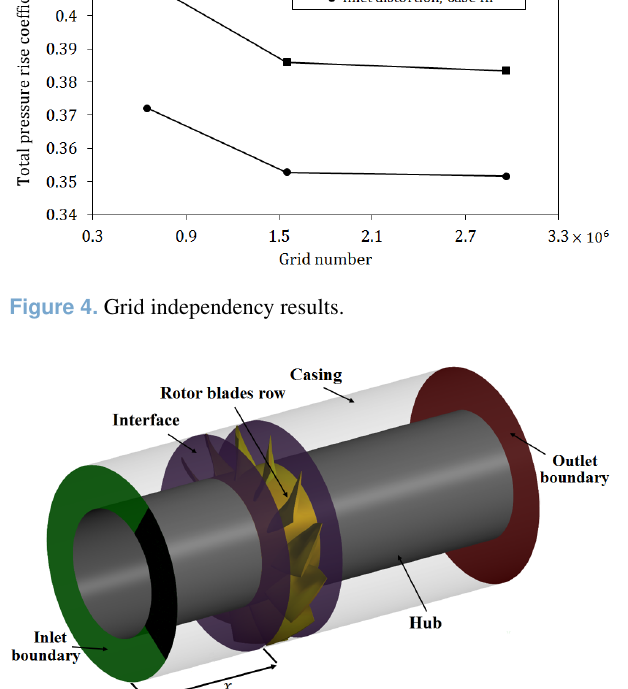
Inlet distortion is enforced by different configurations of screens embedded upstream the rotor blade row. Figure 2 shows geometries of these screens (cases II to VI) together with the non-distorted case (case I). All these distortion pressor annulus passage by 25 %.